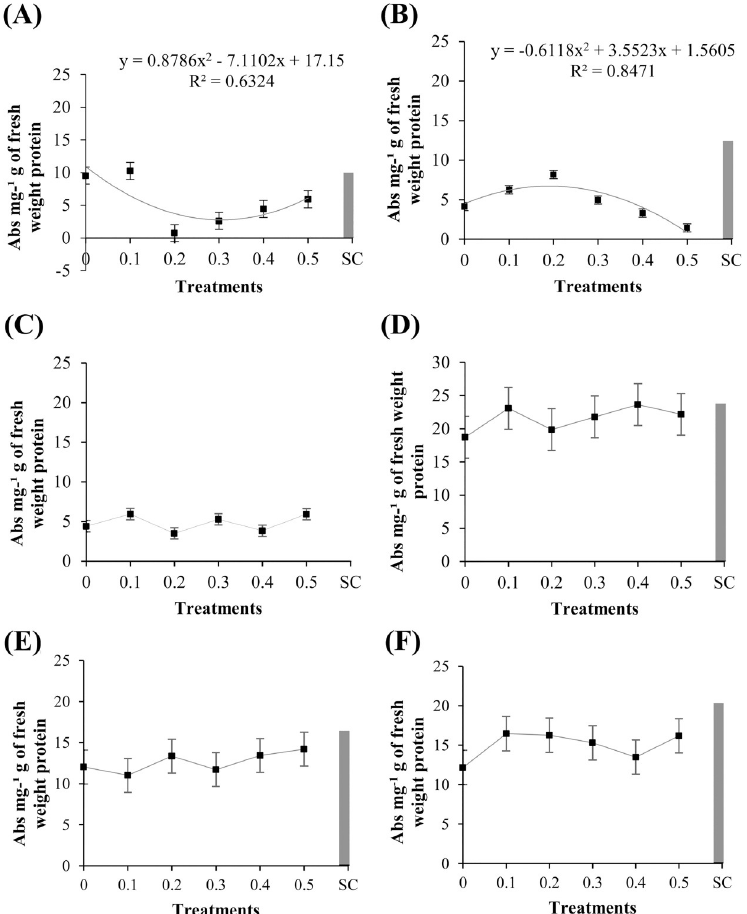
Fig 6. Total protein content in ‘Monsoy 8372 IPRO,’ ‘TMG 132 RR,’ and nontransgenic ‘TMG 4182’ treated with different concentrations of R . guttatus and R . marina (0.1, 0.2, 0.3, 0.4, and 0.5 mg/mL), sterile water (0), and S . cerevisiae (SC). Cultivars treated with R . guttatus cutaneous secretions (species 1): ( A ) ‘Monsoy 8372 IPRO’; ( B ) ‘TMG 132 RR’; and ( C ) nontransgenic ‘TMG 4182’. Cultivars treated with R . marina cutaneous secretions (species 2): ( D ) ‘Monsoy 8372 IPRO’; ( E ) ‘TMG 132 RR’; and ( F ) nontransgenic ‘TMG 4182’. Data are the mean of three independent experiments. Data when significant were subjected to regression analysis (P � 0.05), adjusting the regression equations (R 2 ). Treatment with S . cerevisiae was used as an additional control. Metric bars indicate the standard error of the mean